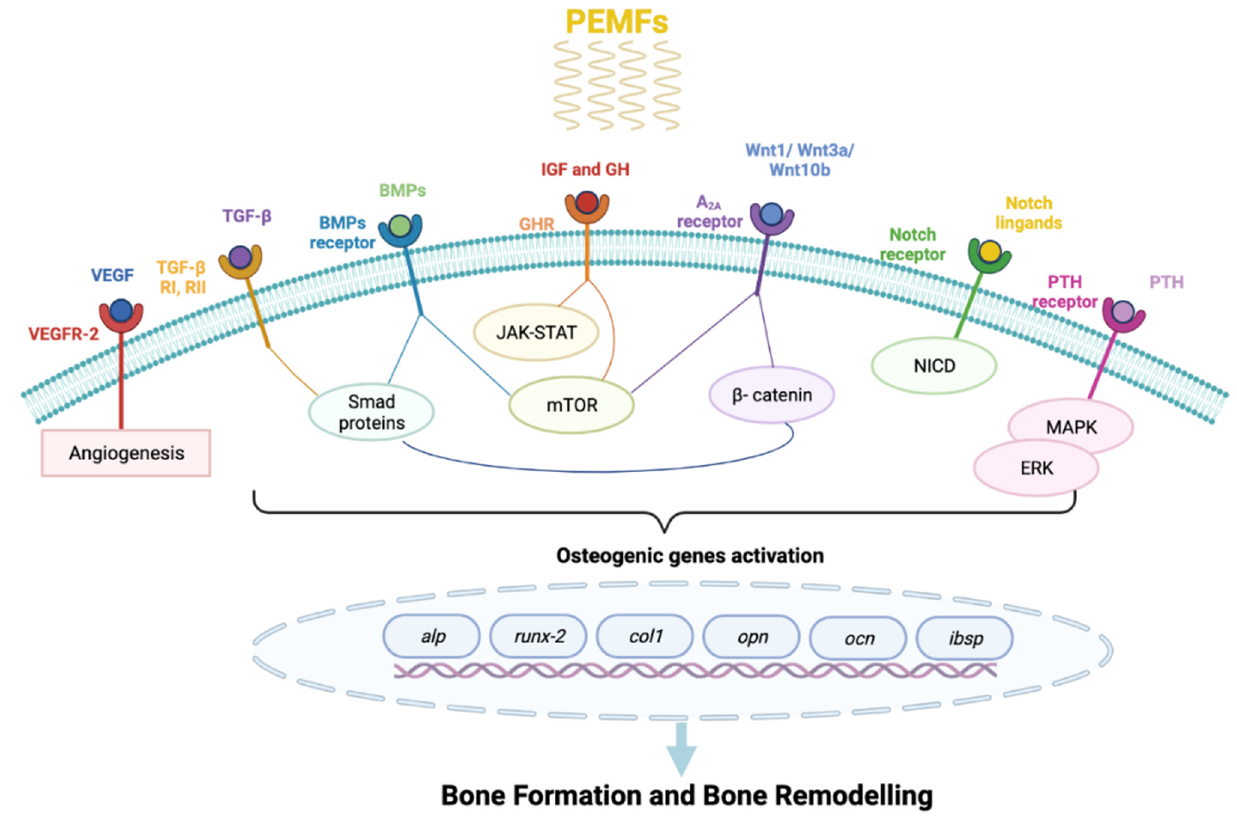
Figure 1. Schematic representation of molecular pathways activated by pulsed electromagnetic fields (PEMFs). Abbrevia- tions: A2A (adenosine receptor); alp (alkaline phosphatase gene); BMPs (bone morphogenetic proteins); ibsp (bone sialo- protein gene); col1 (collagen type 1 gene); ERK ( extracellular signal-regulated kinase 1/2); GH (growth hormone); GHR (growth hormone receptor); IGF (insulin-like growth factor); JAK-STAT (Janus kinase- signal transucer activating the tran- scription); MAPK (mitogen-activated protein kinase); mTOR (mammalian-mechanistic target of rapamycin); NICD (Notch intracellular domain); ocn (osteocalcin gene); opn (ostepontin gene); PTH (parathyroid hormone); runx-2 (runt-related- transcription factor 2 gene); SMAD proteins (small mothers against decapentaplegic); TGF- β (transforming growth factor- β ); TGF- β RI/RII (TGF- β receptor I/receptor II); VEGF (vascular endothelial growth factor); VEGFR-2 (vascular endothelial growth factor receptor 2).